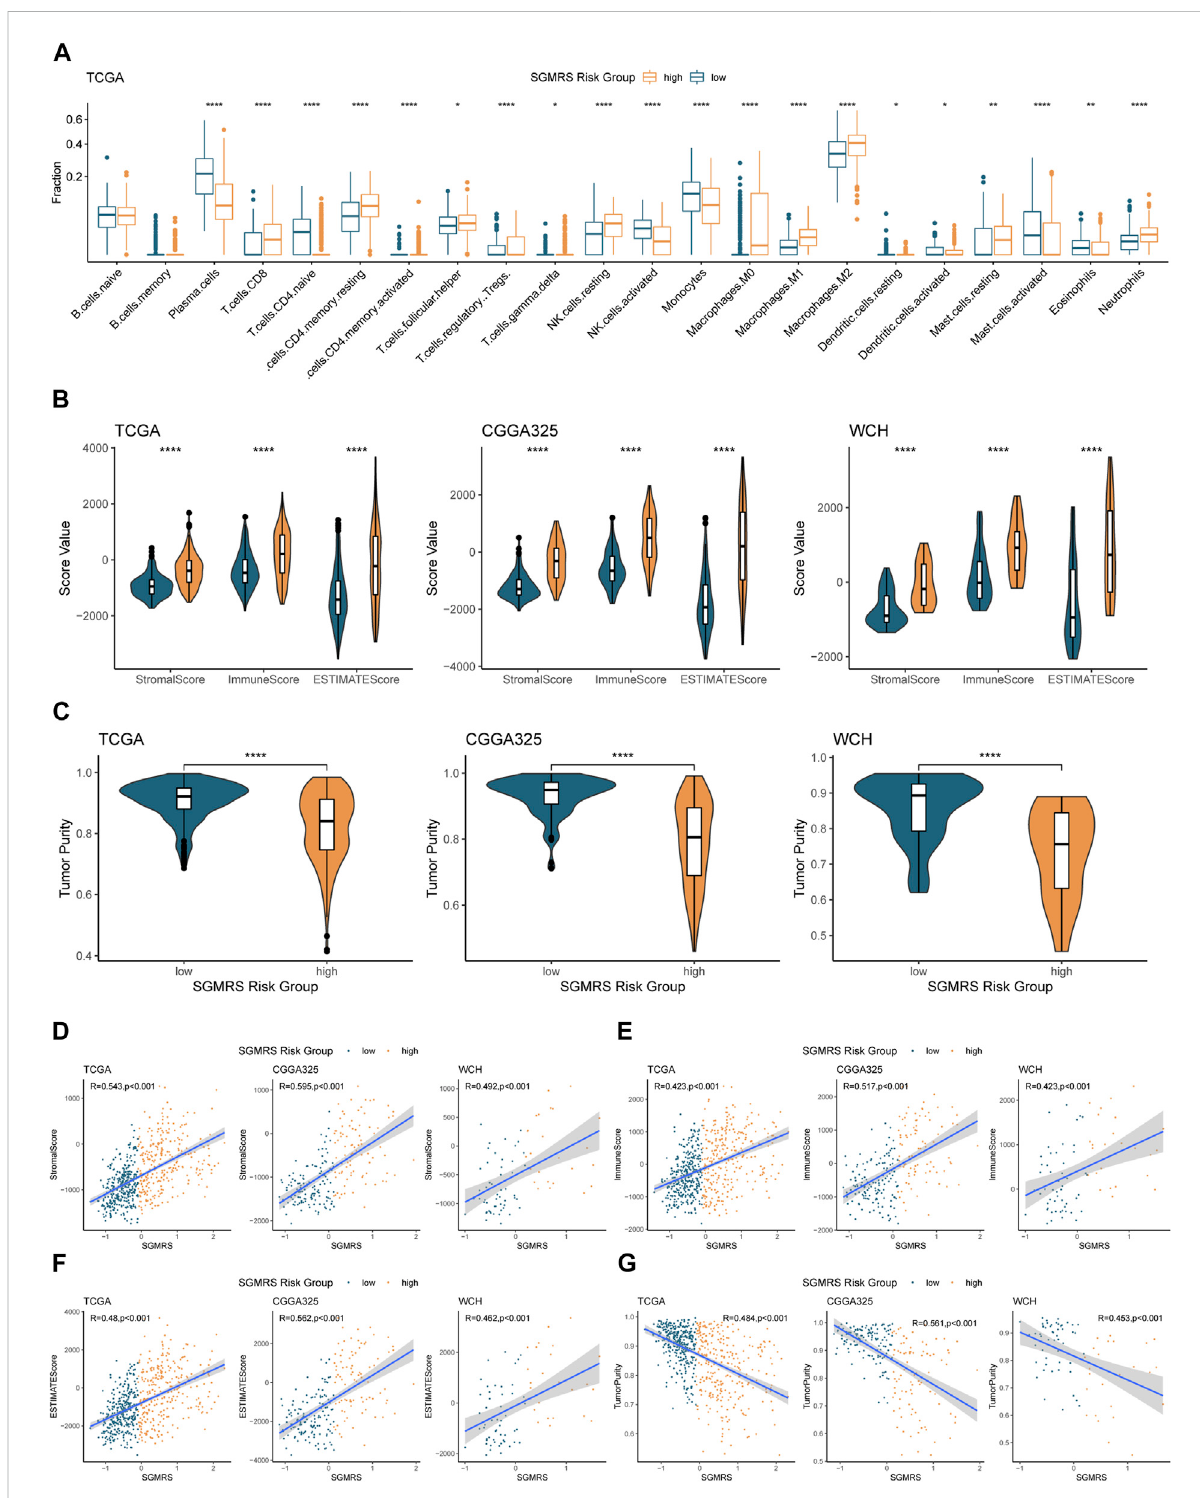
FIGURE 8 Analyses on immune landscapes of tumor microenvironment between SGMRS high- and low-risk groups. (A) Boxplot for the estimated in fi ltration fraction of 22 types of immune cells in tumors. (B) Differences in the stromal, immune, and ESTIMATE scores between two risk groups in TCGA, CGGA325, and WCH cohorts. (C) Differences intumor purity between two risk groups in TCGA, CGGA325, and WCH cohorts. (D) Analyses of correlations of SGMRS with the (D) stromal score, (E) immune score, (F) ESTIMATE score, and (G) tumor purity in TCGA, CGGA325, and WCH cohorts. * p < 0.05; ** p < 0.01; *** p < 0.001; **** p <